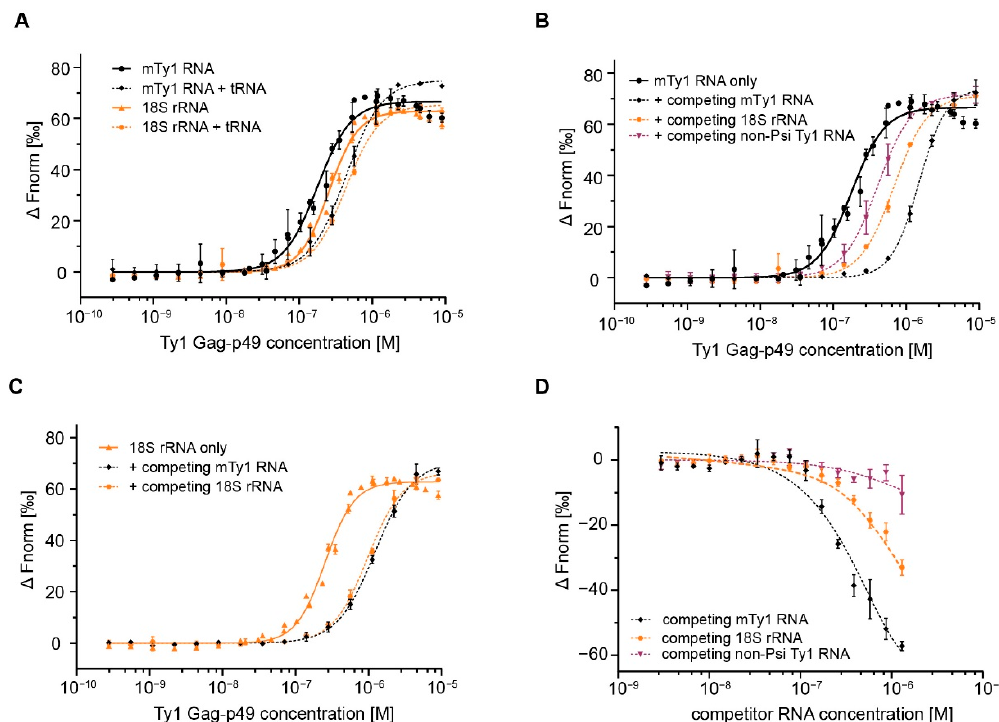
Figure 3. MST analysis of Ty1 Gag ‐ p49 interactions with RNA in the presence of competitor RNA. ( A ) Dose–response binding curves of Ty1 Gag ‐ p49 to mTy1 RNA (black) and 18S rRNA (orange) in the presence (dashed lines) or absence (solid lines) of total E. coli tRNA in 50 ‐ fold molar excess. ( B ) Dose–response binding curves of Ty1 Gag ‐ p49 to mTy1 RNA in the presence of competing mTy1 RNA (black, dashed line), non ‐ Psi Ty1 RNA (purple, dashed line) or 18S rRNA (orange, dashed line) in constant 10 ‐ fold molar excess. mTy1 RNA binding by Ty1 Gag ‐ p49 in 150 mM NaCl lacking competitor RNA is used as a control (black, solid line) ( C ) Dose–response binding curves of Ty1 Gag ‐ p49 to 18S rRNA in the presence of competing mTy1 RNA (black, dashed line) or 18S rRNA (orange, dashed line) in 10 ‐ fold molar excess. 18S rRNA binding by Ty1 Gag ‐ p49 in 150 mM NaCl lacking competitor is used as a control (orange, solid line) ( D ) Dose ‐ response binding curves of Ty1 Gag ‐ p49 to mTy1 RNA in the presence of an increasing concentration of competing mTy1 RNA (black), non ‐ Psi Ty1 RNA (purple) or 18S rRNA (orange).